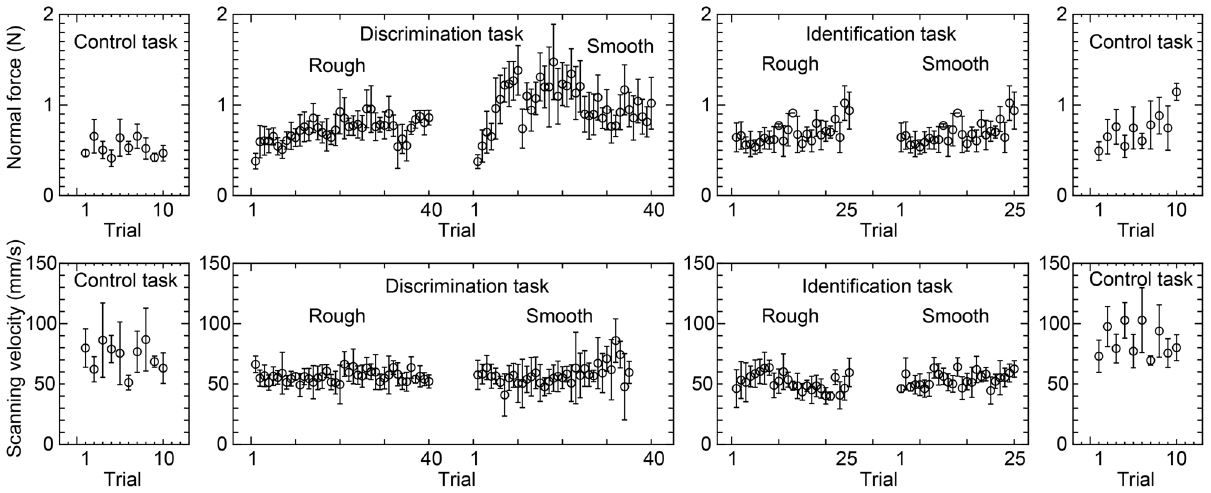
Figure 5. An example of data collected in the experiment for one participant. Each plot shows the average and the standard deviation of the normal force or scanning velocity for each trial.